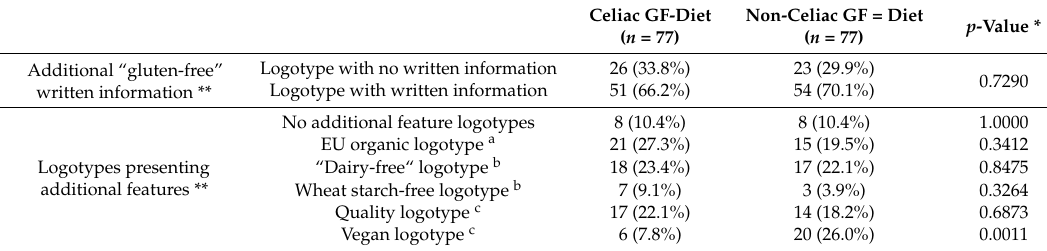
Table 4. The comparison of the front-of-package “gluten-free” (GF) product labeled attributes influencing the choice of GF bread in subgroups of celiac GF-diet and non-celiac GF-diet participants.